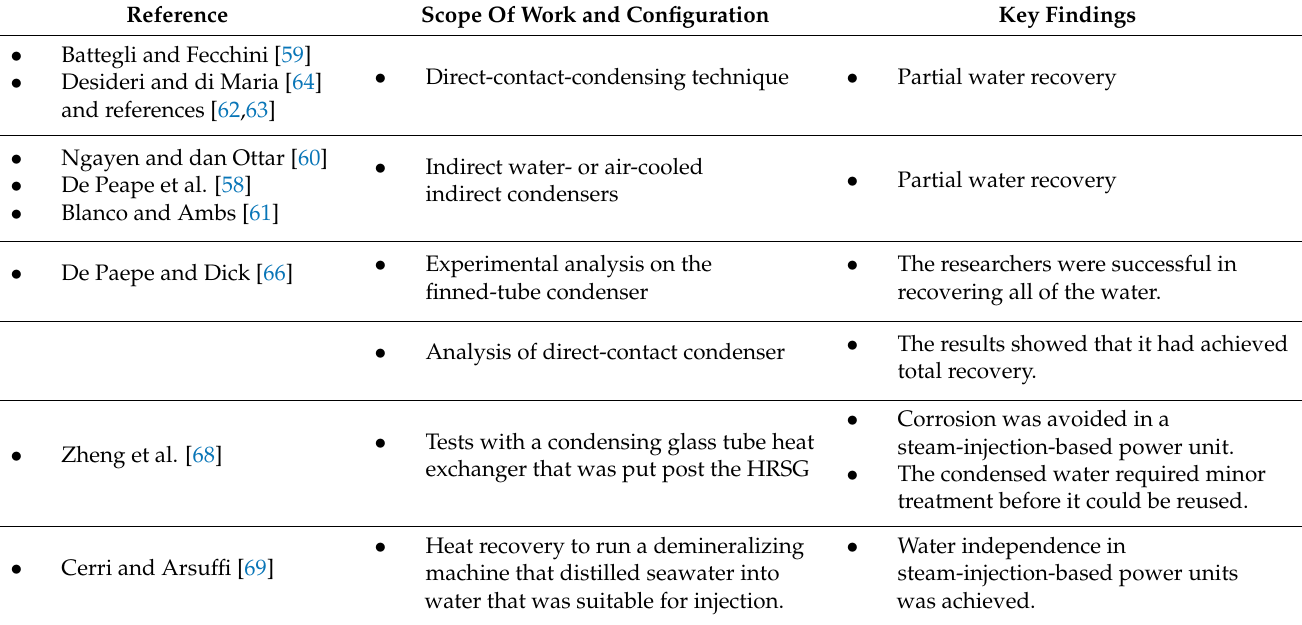
Table 3. A summary of the key efforts on water recovery and water quality. Reference Scope Of Work and